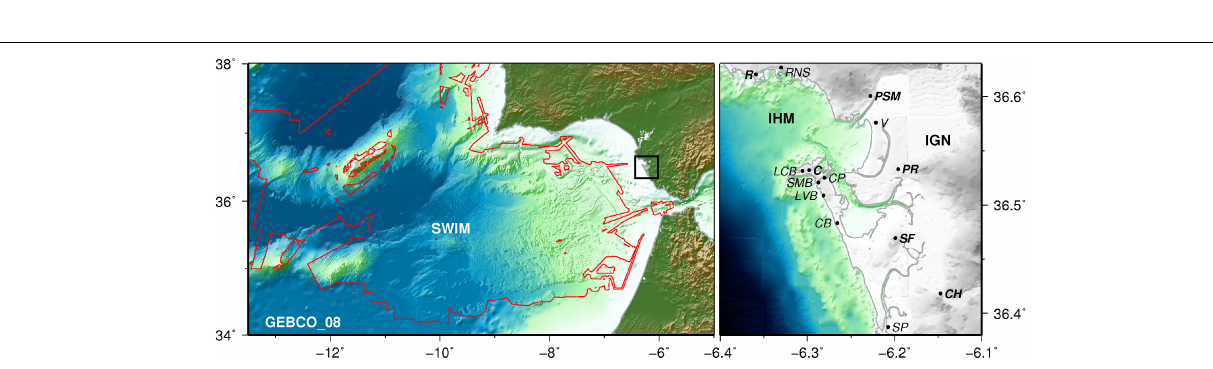
Frontiers in Earth Science |